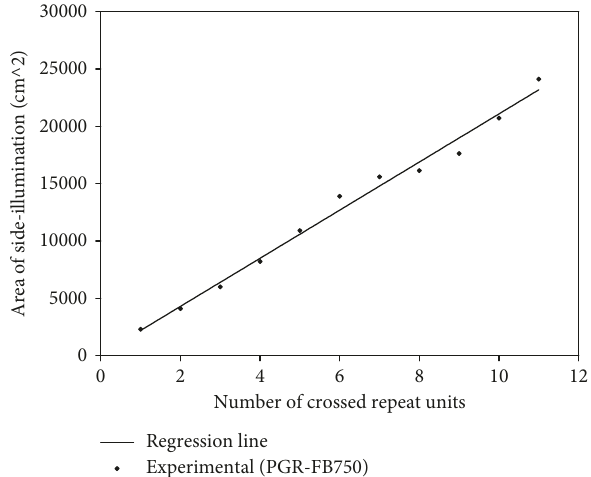
Figure 16: Comparison of area of side-illumination according to number of crossed repeat